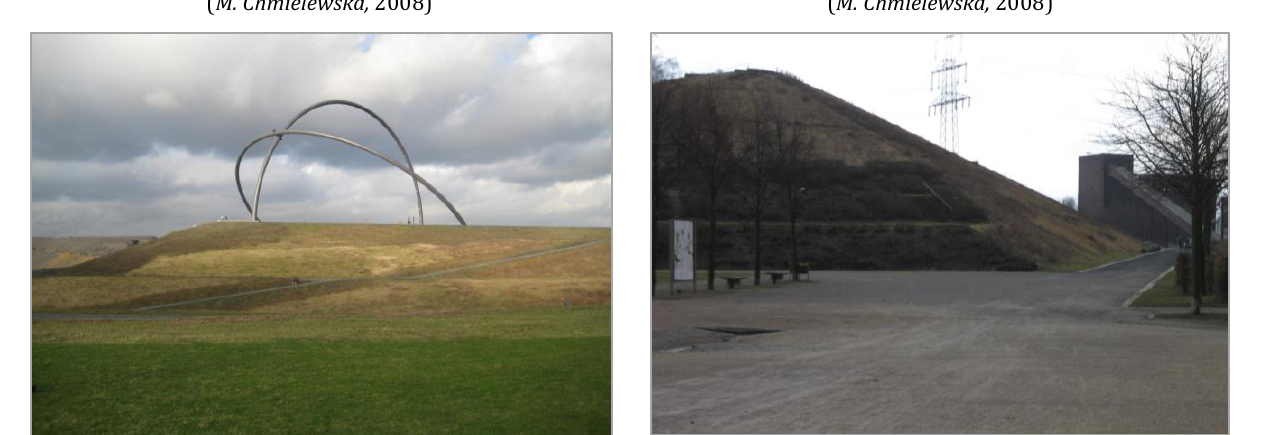
Fig. 5. The landmark at the top of the Schurenbach tip